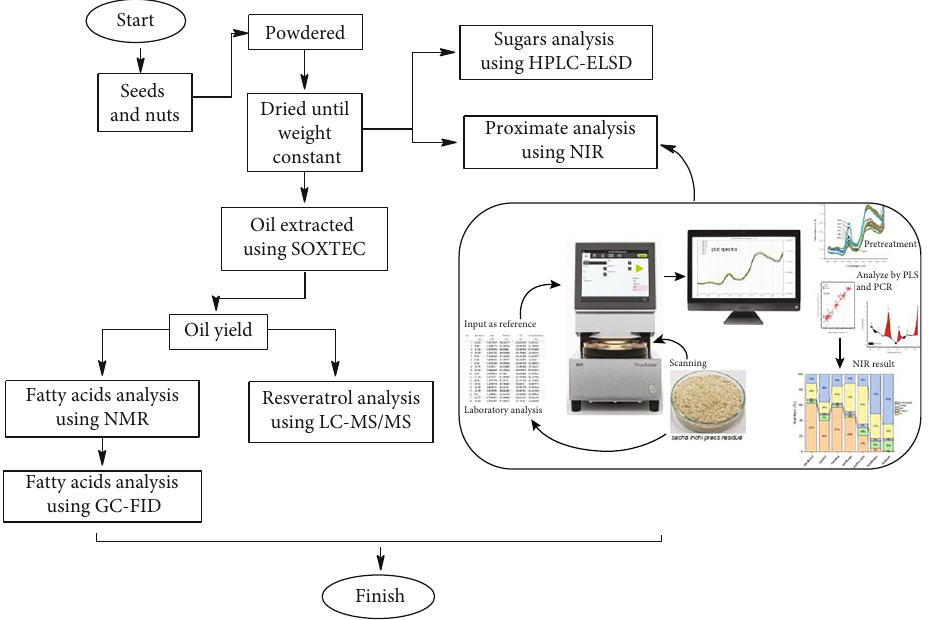
Figure 1: Flowchart nutrient